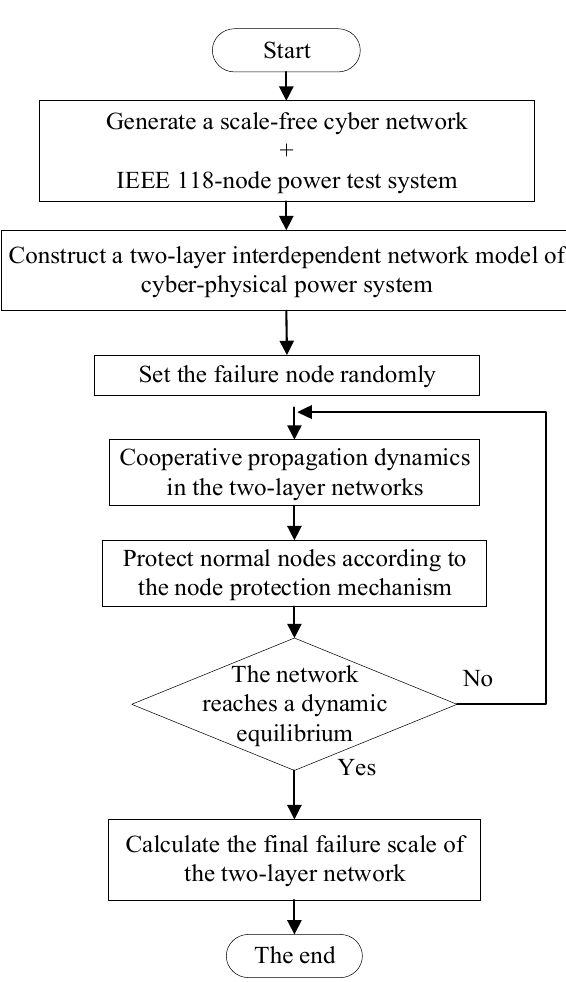
Figure 5. Flowchart of simulation analysis.